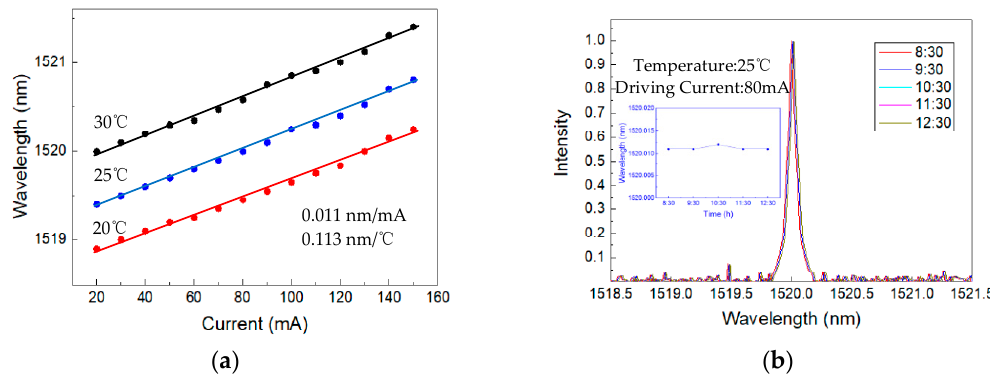
Figure 4. ( a ) Curve of the laser’s emitting peak wavelength versus the driving current at 20 °C, 25 °C, and 30 °C. ( b ) Curve of the laser’s emitting peak wavelength during four hours of continuous operation.